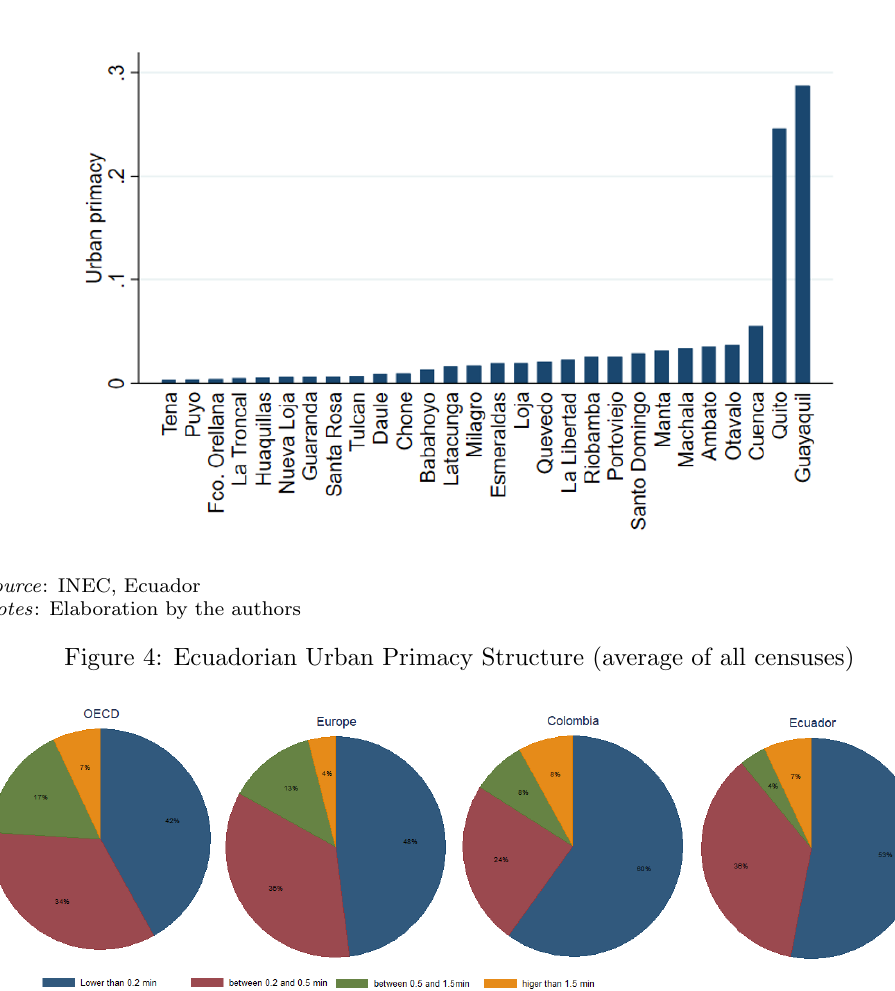
Figure 5: FUAs size classification in the year